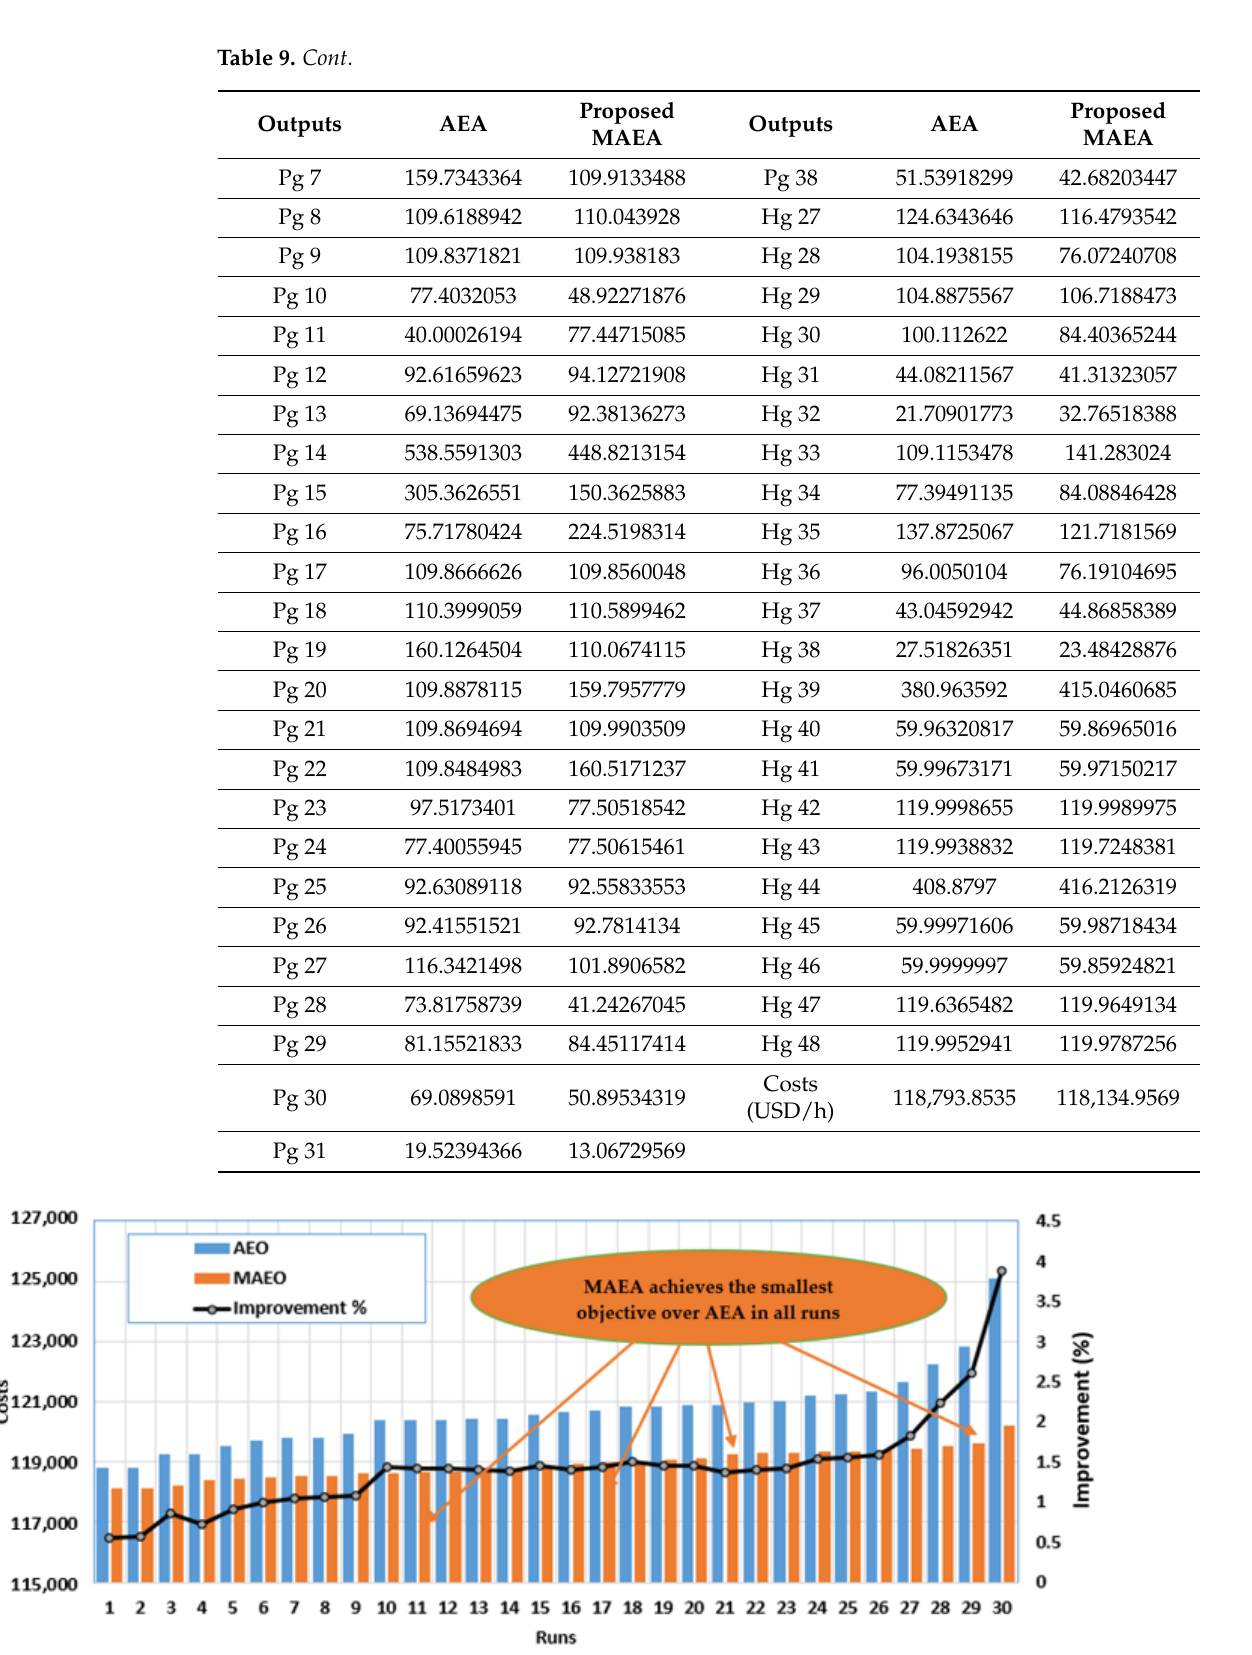
Figure 13. Obtained costs for all simulated runs of the proposed MAEA and the basic AEA of Case 4.